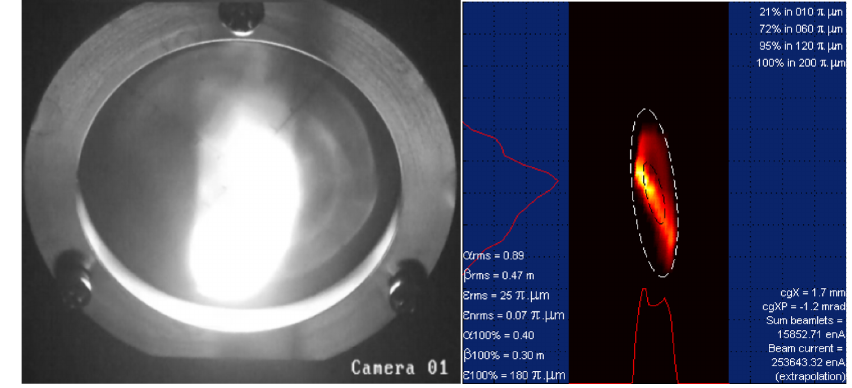
FIG. 24. Emittance measurement after the dipole